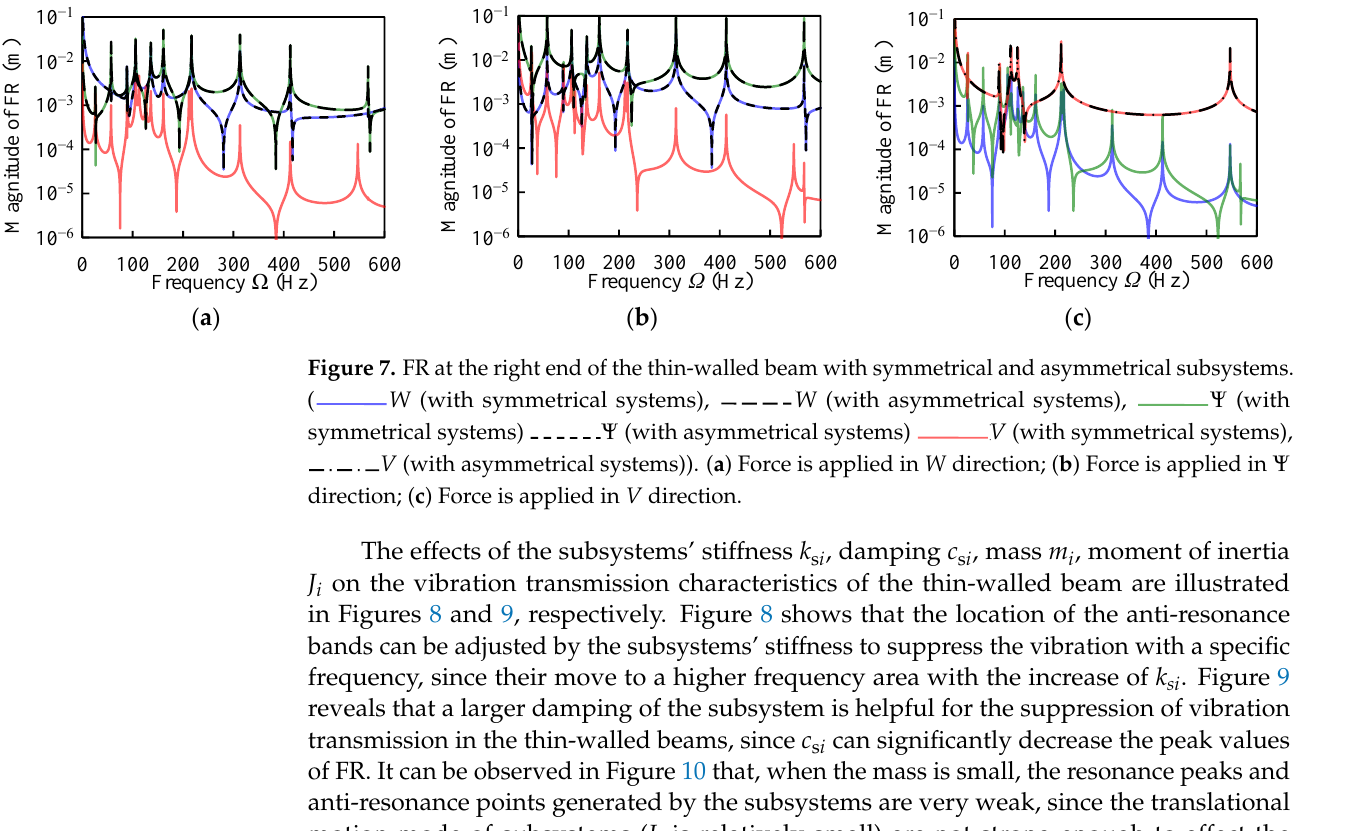
Figure 6. Frequency response of the bare beam at P 1 , P 2 , P 4 , and P 5 with force applying at P 1 . ( FR at P 1 , FR at P 2 , FR at P 4 , FR at P 5 ).